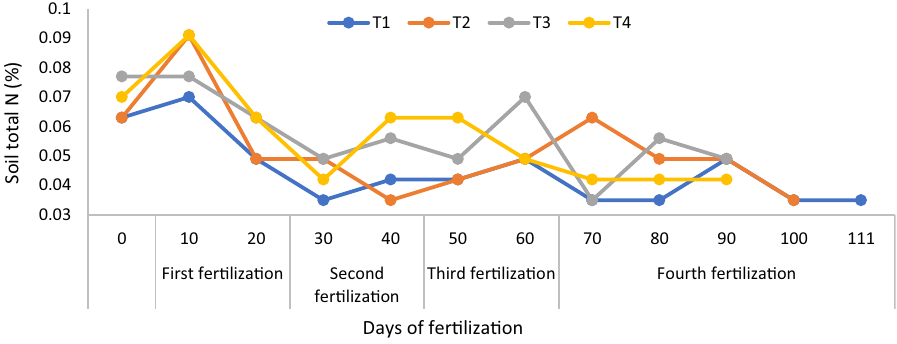
Figure 2. Improving soil total nitrogen concentration using chicken litter biochar in MR219 rice cultivation.